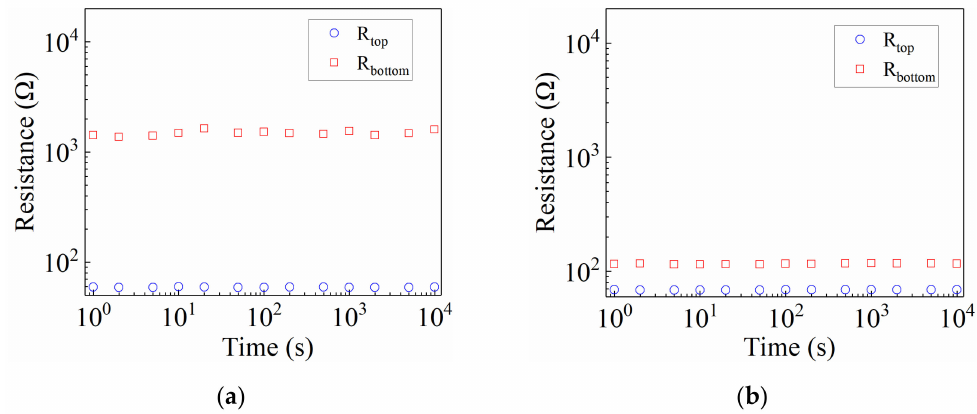
Figure 16. Resistance values of the RRAMs during unmasking-masking operation for 10 4 s. Initially, ‘1’ was written to the cell: ( a ) after unmasking; ( b ) after